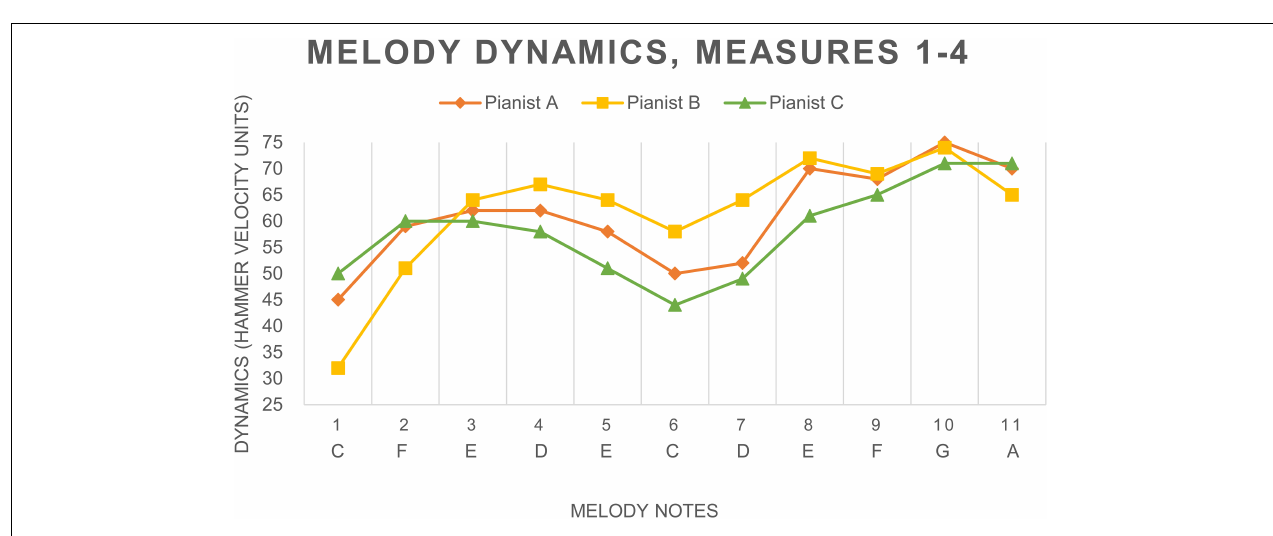
FIGURE 6 | Sonification score, model C, measures 1–4.